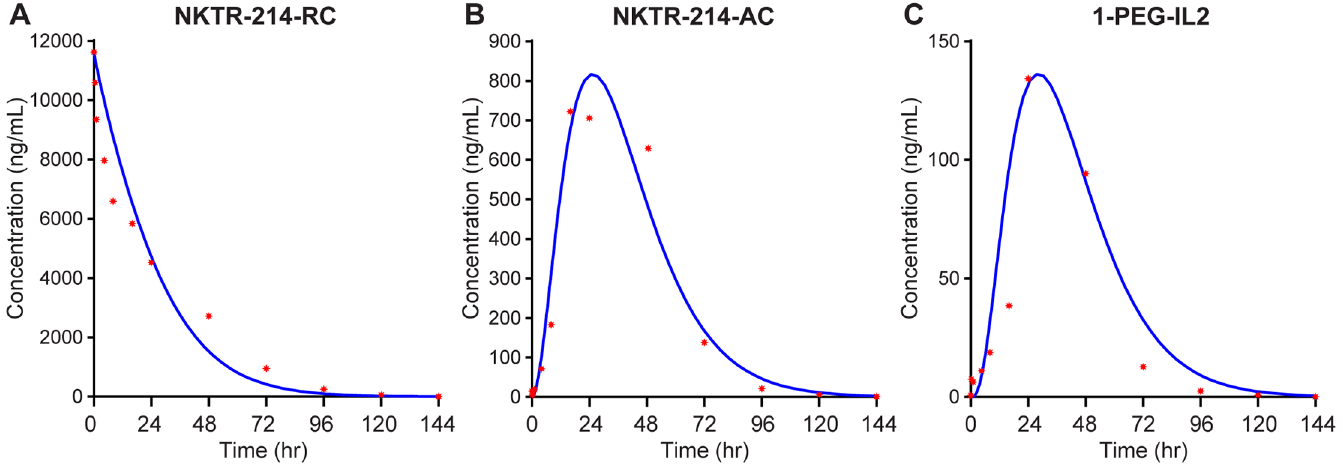
Fig 8. The model suitably fits to measuredNKTR-214concentration-time profiles. Summingthe concentration-time profile of the individualmodel- derived conjugated-IL2 fit well to the experimentally determined concentration-time profilesof A. NKTR-214-RC, B. NKTR-214-AC, and C. 1-PEG-IL2, the most active conjugatederived from NKTR-214. Solid lines represent the simulationand individual red symbols represent the experimental data.